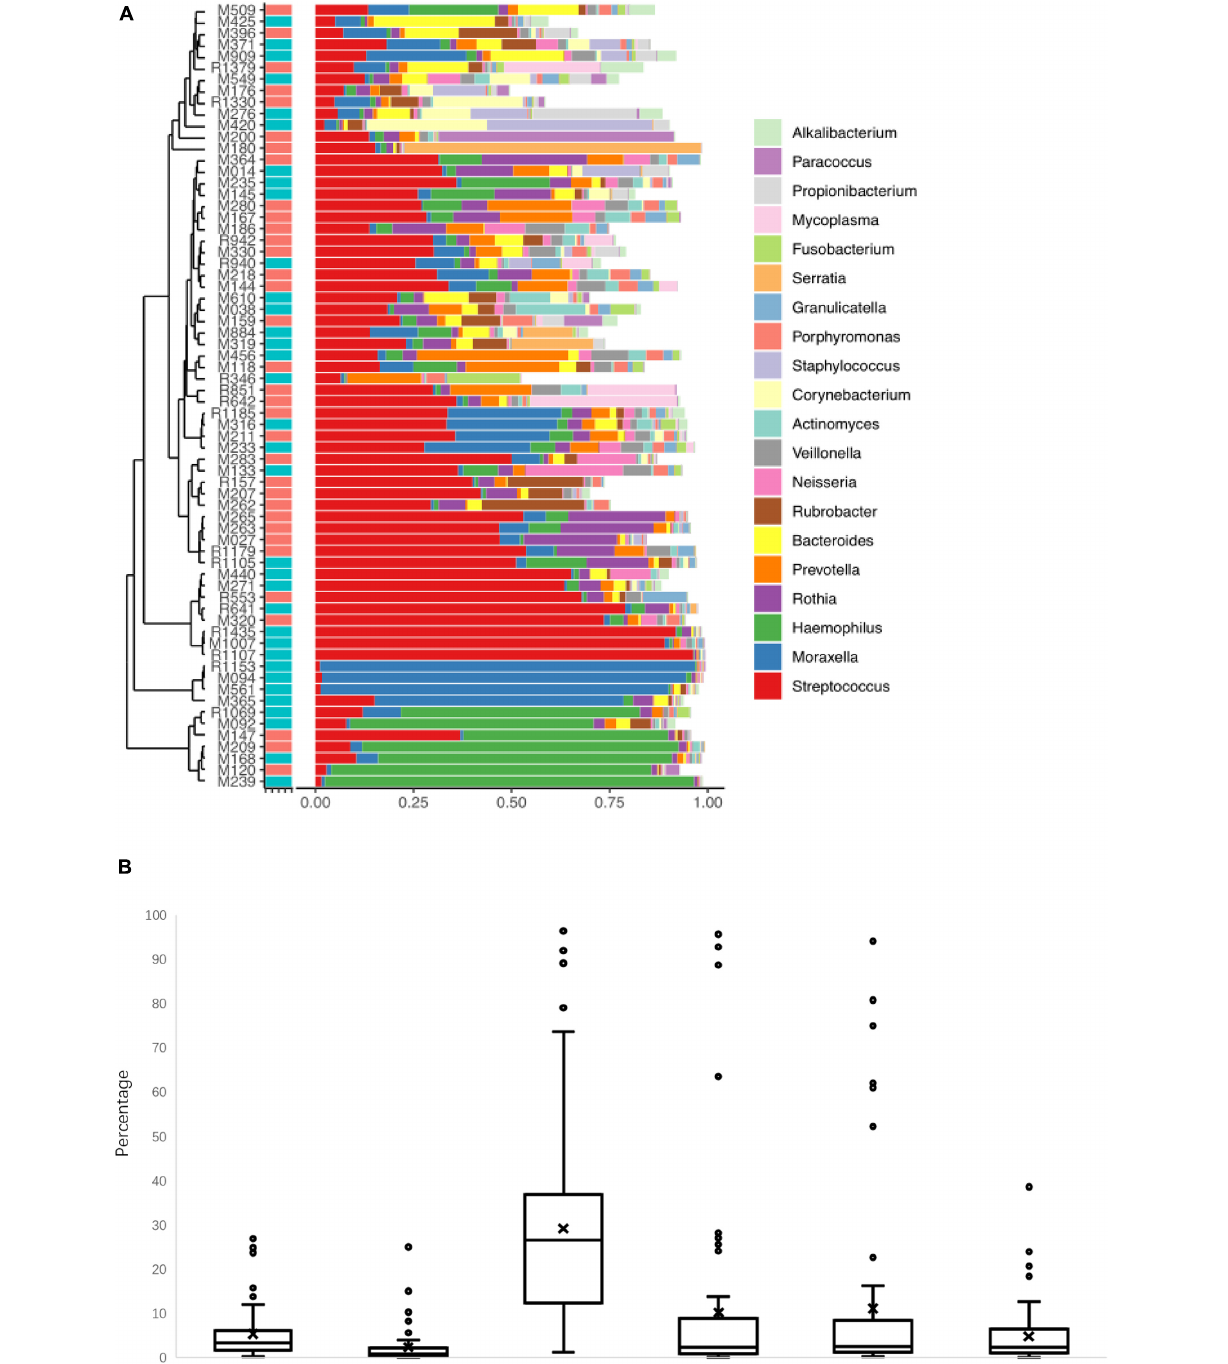
To clarify which specific bacteria caused the different patterns between groups, we examined the difference in the relative abundance of the bacteria between the cohorts at the genus